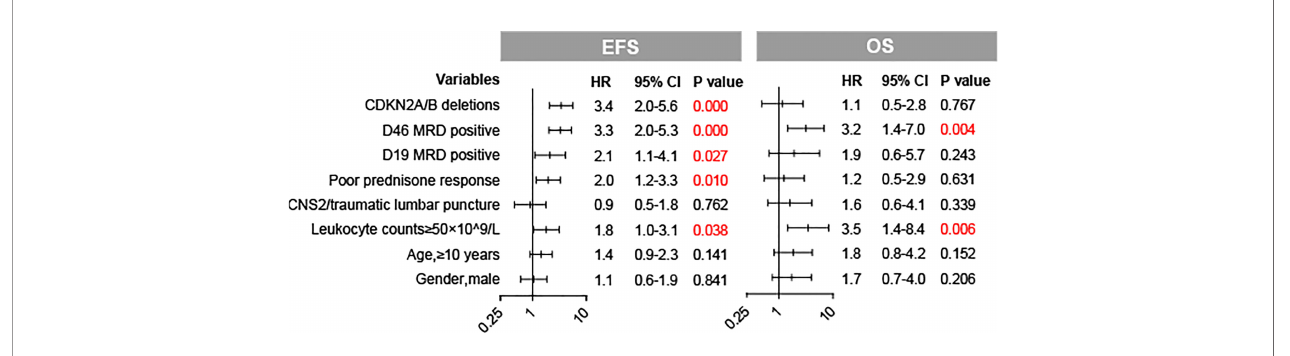
FIGURE 3 | Forest plots of the multivariate analysis of CDKN2A/B deletions and baseline factors for EFS and OS in